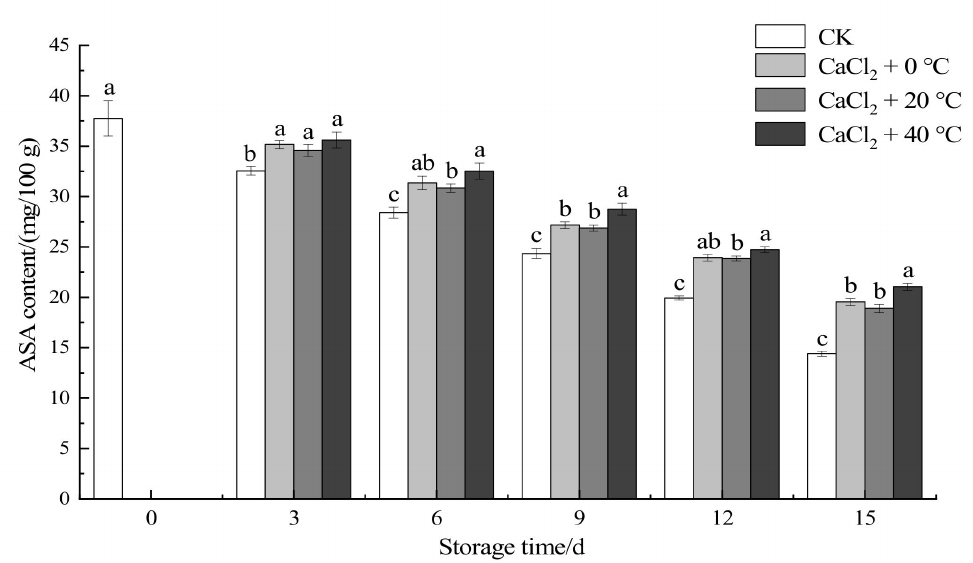
Figure 3. Effect of the different treatments on the ASA content of fresh-cut “Xuebai” cauliflower florets. Error bars indicate standard deviation (SD); the statistical significance between the four groups that passed the Tukey significance test is expressed in different lowercase letters, and the significance level is p <